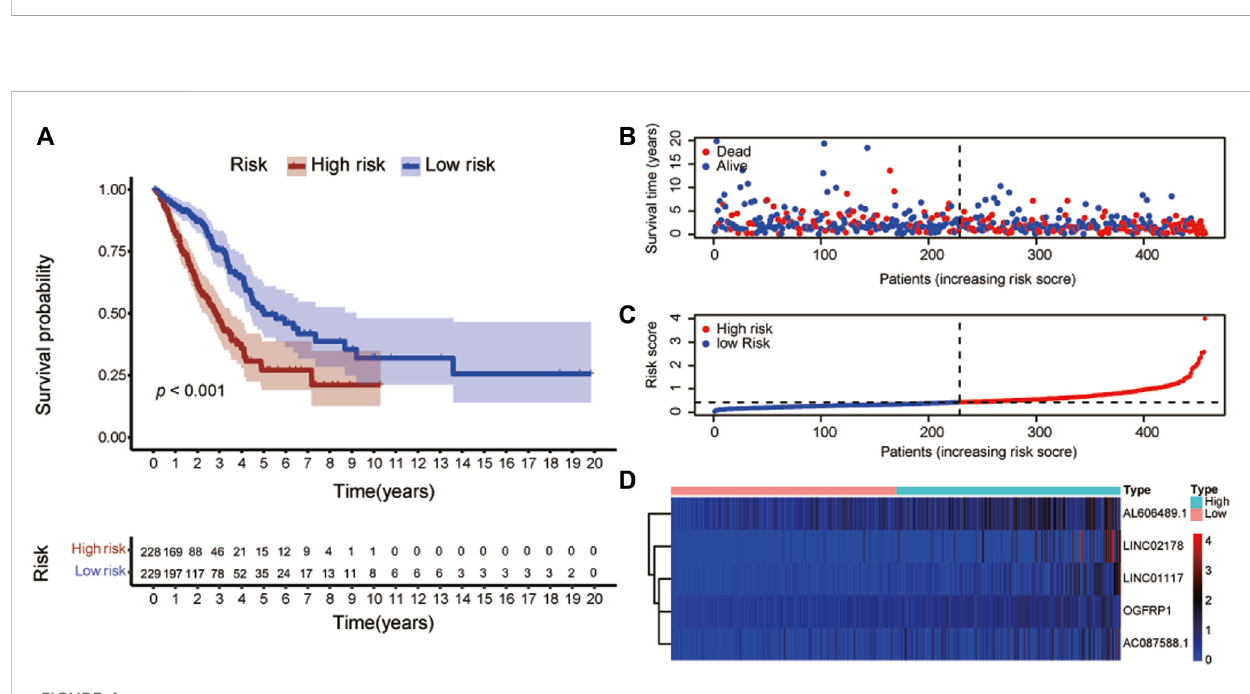
FIGURE 4 Establishment of the risk score model utilizing ERS-related lncRNAs. (A) Kaplan-Meier analysis showed that the patients in the high-risk group had a signi fi cantly lower overall survival than that in the low-risk group. (B) The survival status for each patient. (C) Distributions of patient risk ratings.